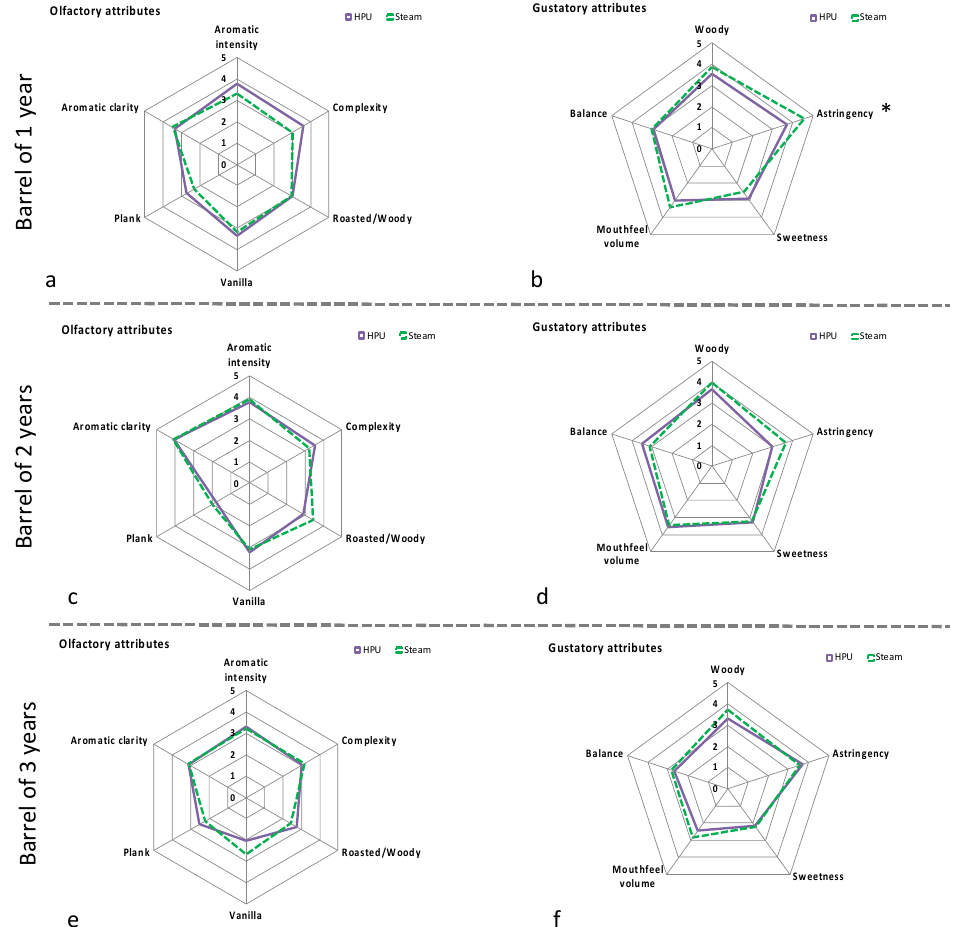
Figure 5. Sensory evaluation (olfactory and gustatory) of red wine aging for 12 months in barrels of 1 ( a , b ), 2 ( c , d ), or 3 years old ( e , f ) cleaned with HPU hw or steam. (*) significant at p < 0.05.